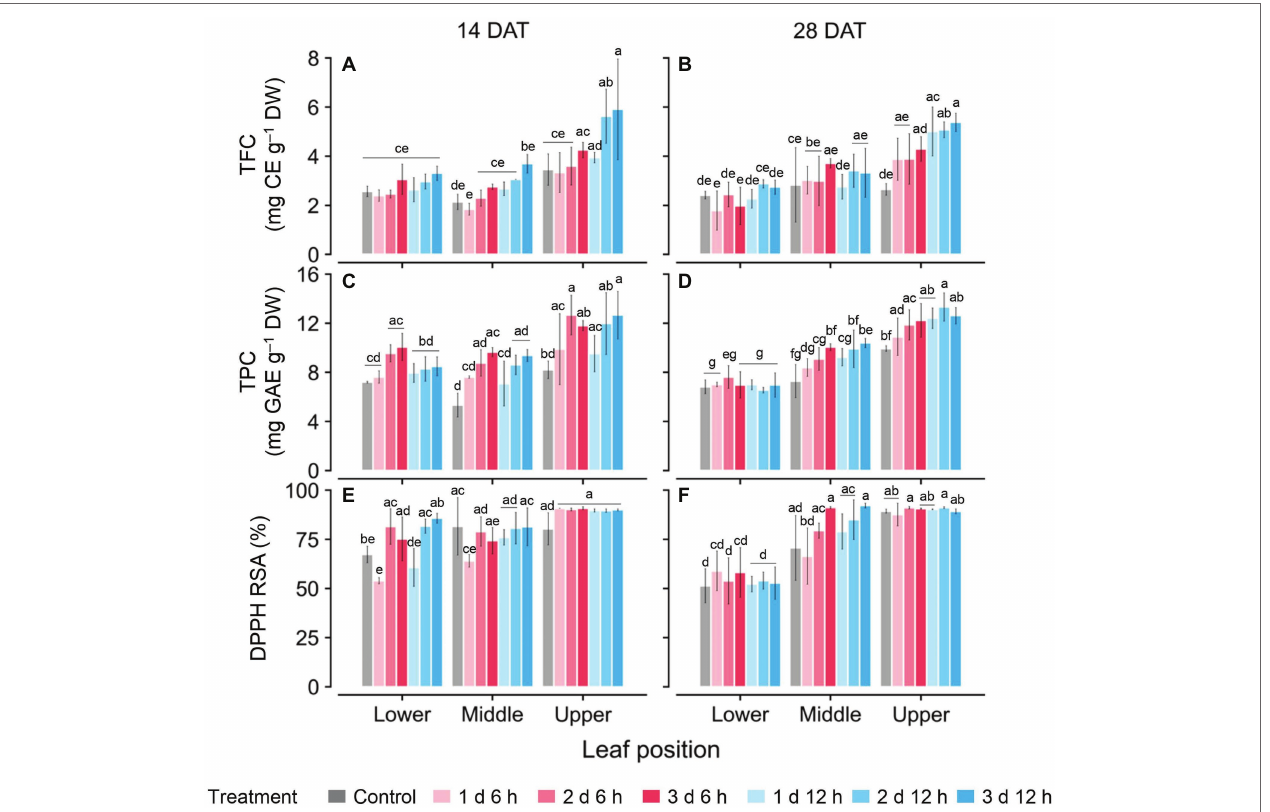
FIGURE 5 | Concentrations of total flavonoid compounds (TFC; A,B ); total phenolic compounds (TPC; C,D ); and antioxidant capacity represented as DPPH radical scavenging activities (E,F) of kales grown under control and UV-B treatments according to leaf positions at 14 and 28 days after transplanting (DATs). Vertical vars indicate the standard deviation of mean, n = 3. Different letters represent significant differences for each parameter at p < 0.05 by two-way ANOVA and Tukey’s HSD test. Refer to Figure 1C for the UV-B